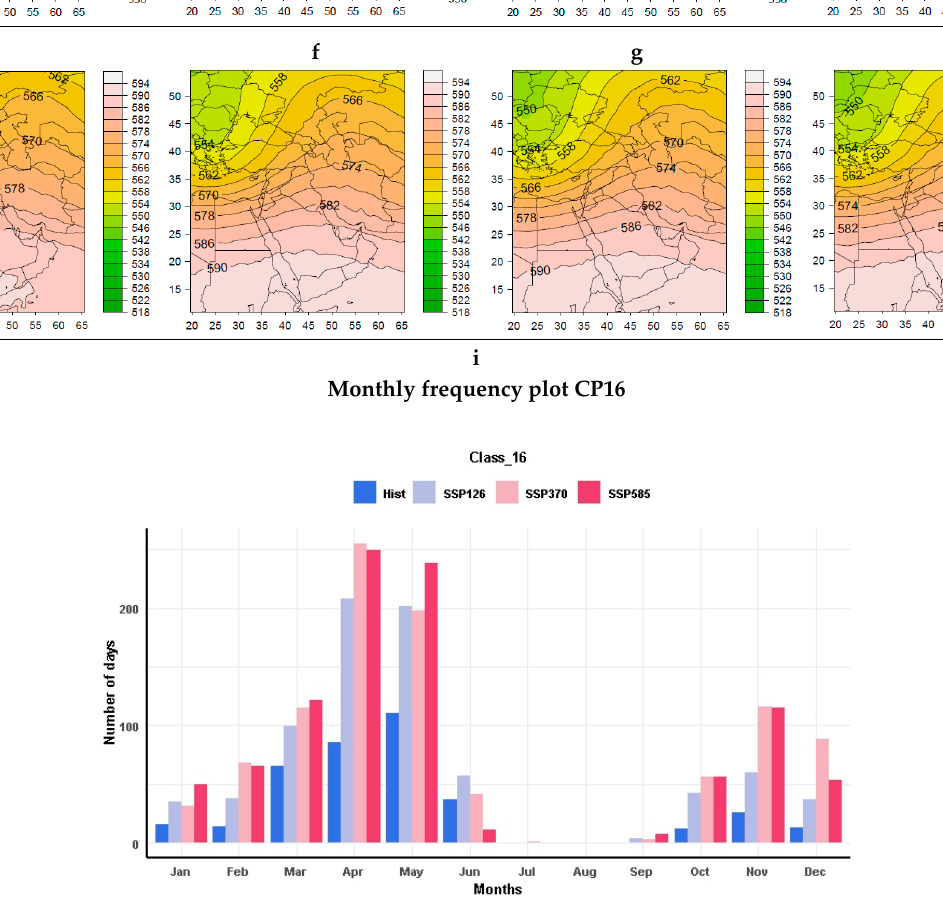
Figure 18. As in Figure 3 for CP16.